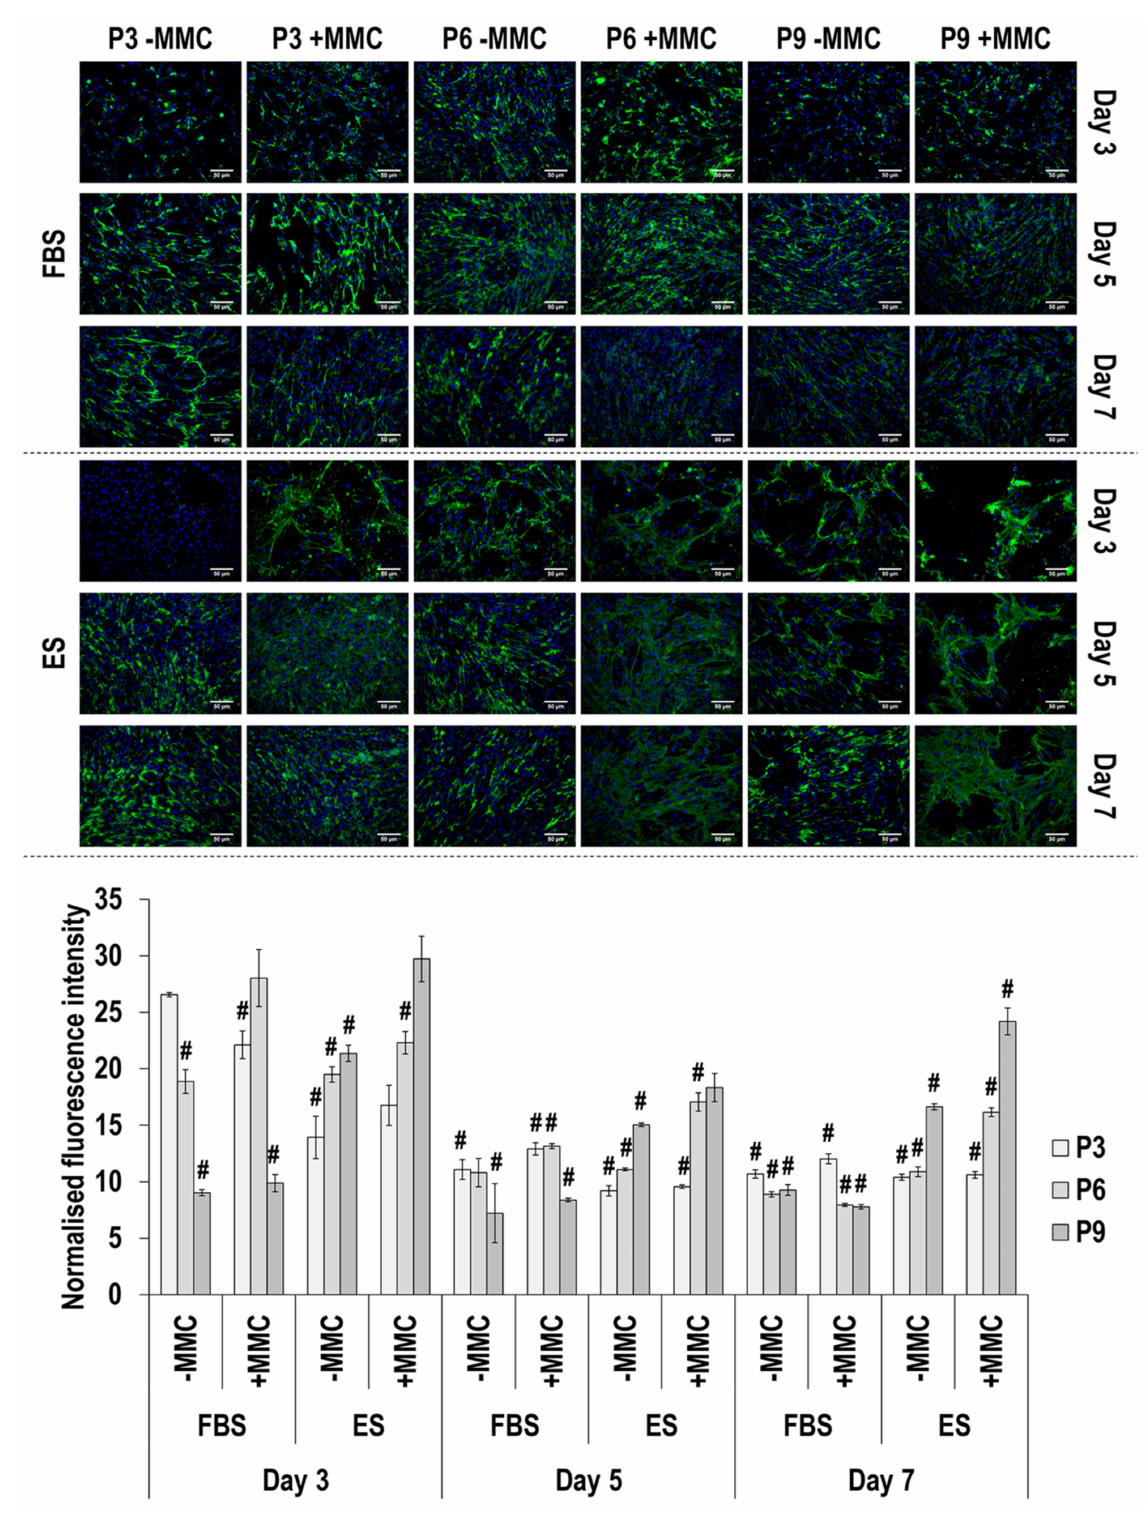
Figure 7. Immunofluorescence and image intensity analysis for fibronectin as a function of serum, passage, MMC and time in culture. Fluorescence intensity was normalised to cell number. # indicates a significant ( p < 0.05) decrease in comparison to cells at passage 3, day 3, in FBS and without MMC. Scale bar: 50 µ